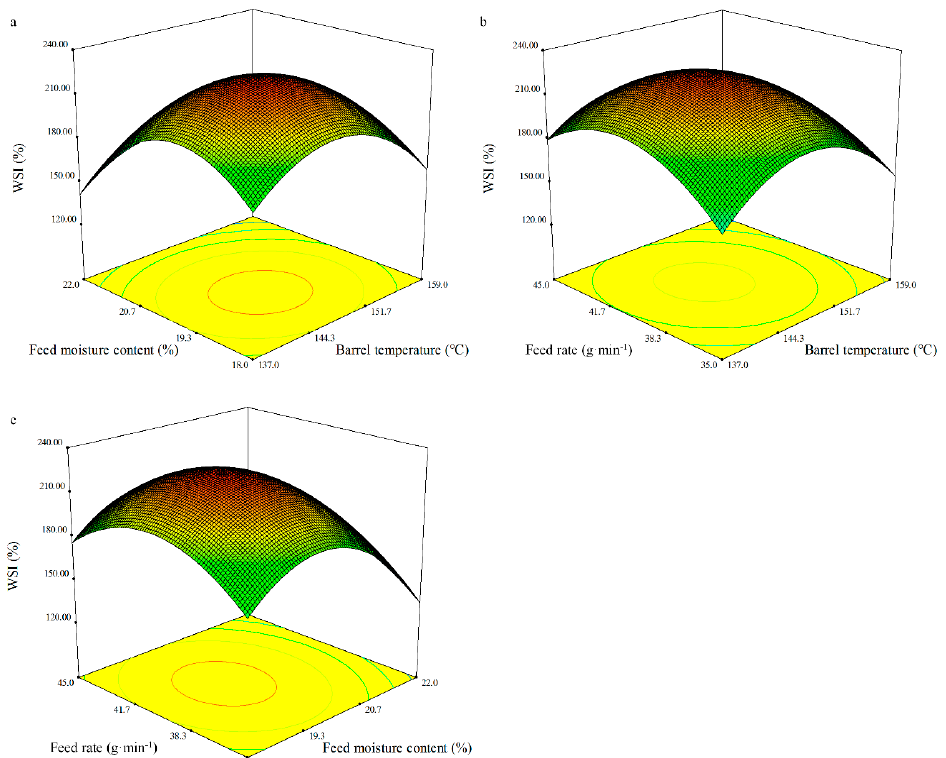
Figure 6. Response surface plot of the WSI of the whole BGW extrudates.